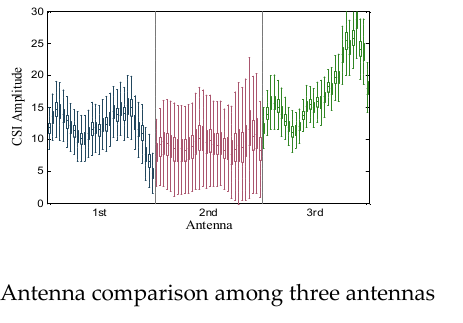
Figure 2. Antenna Selection.